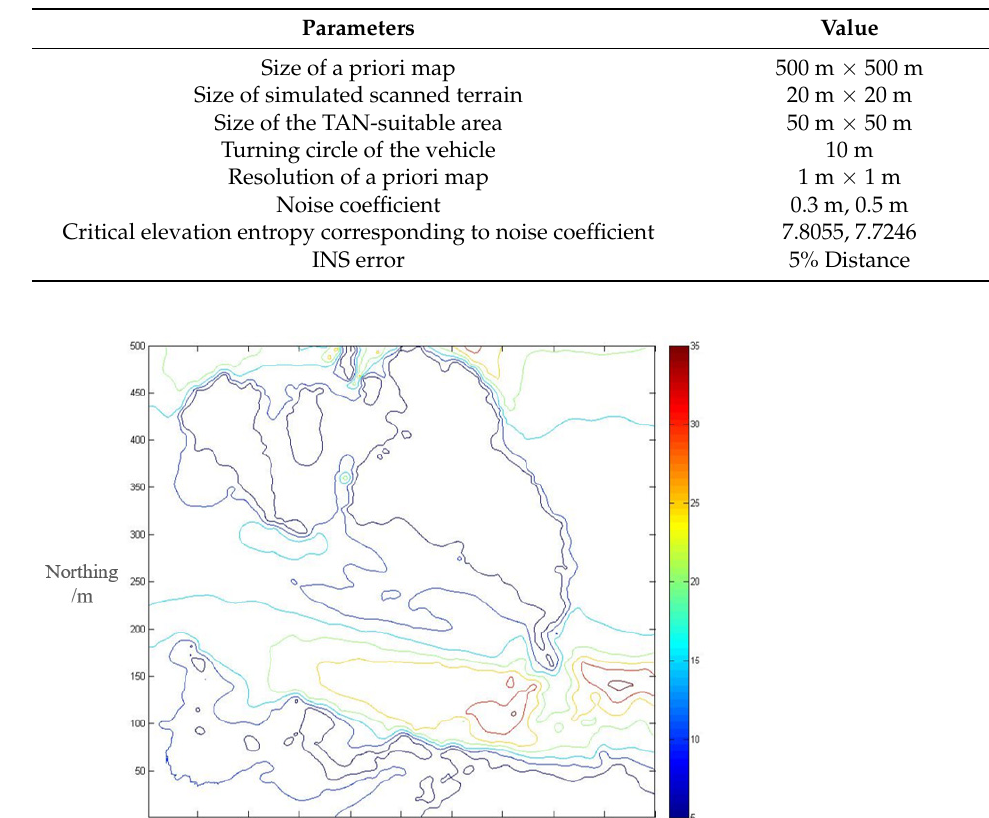
Table 1. Parameters in the simulation.